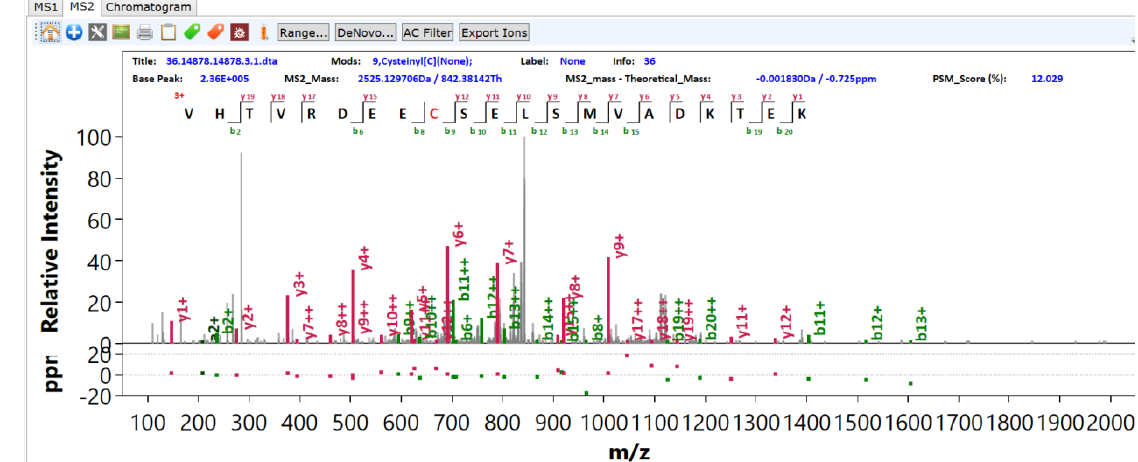
Figure 6. Chemical modifications among the three groups. ( a ) Venn diagram of modification types among the three groups. ( b ) Unsupervised clustering of all the modification types in the three groups. ( c ) An exemplary spectrum of modifications.